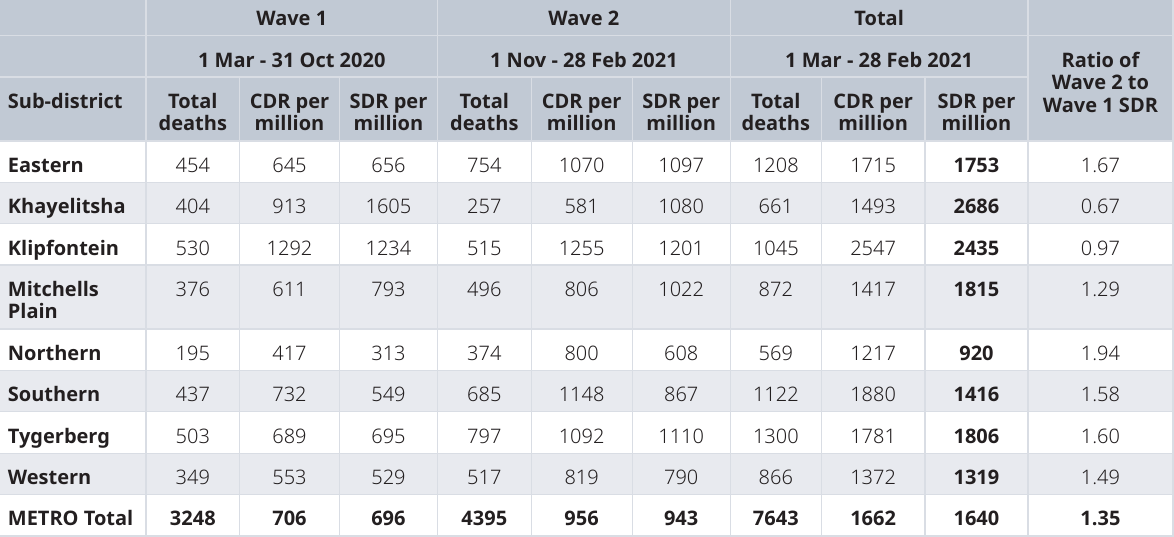
Table 1. Total Number of COVID-19 deaths, Crude Death Rate (CDR) per million and Standardized Death Rate (SDR) per million in the Cape Town Metro, in each wave and by